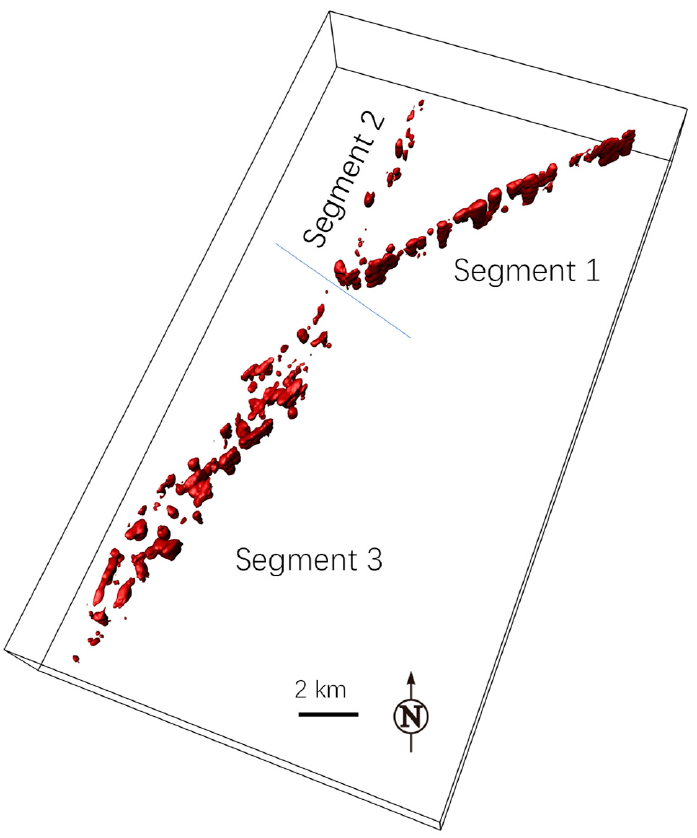
Figure 6. 3D cave reservoirs from the tensor-thickness attribute in the well M1 area.